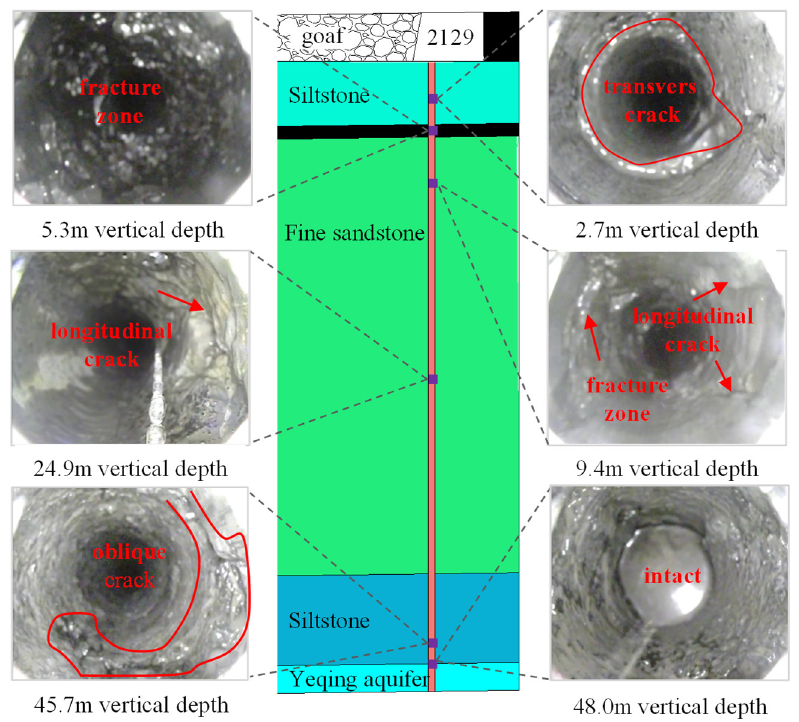
Figure 14. Floor failure depth measurement without roof hydraulic fracturing.